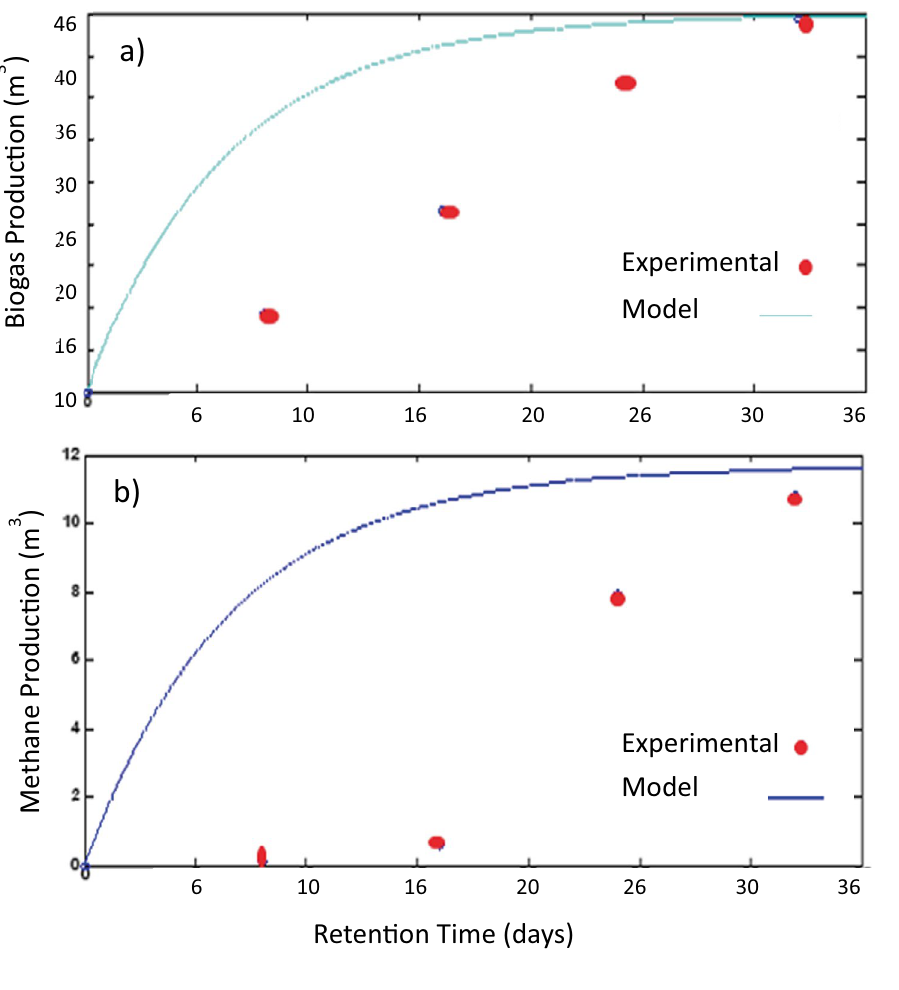
Figure 10. ( a ) Biogas production (m 3 ) as a function of time (days), simulation and experimental results, ( b ) methane gas production (m 3 ) as a function of time (days), simulation and experimental results at 35 ℃